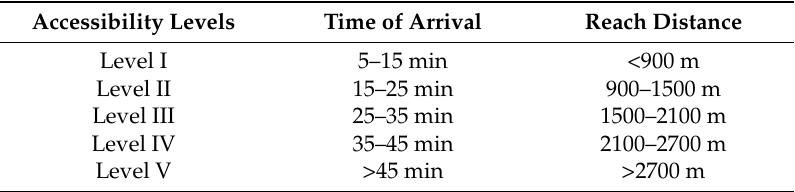
Table 2. Accessibility level division